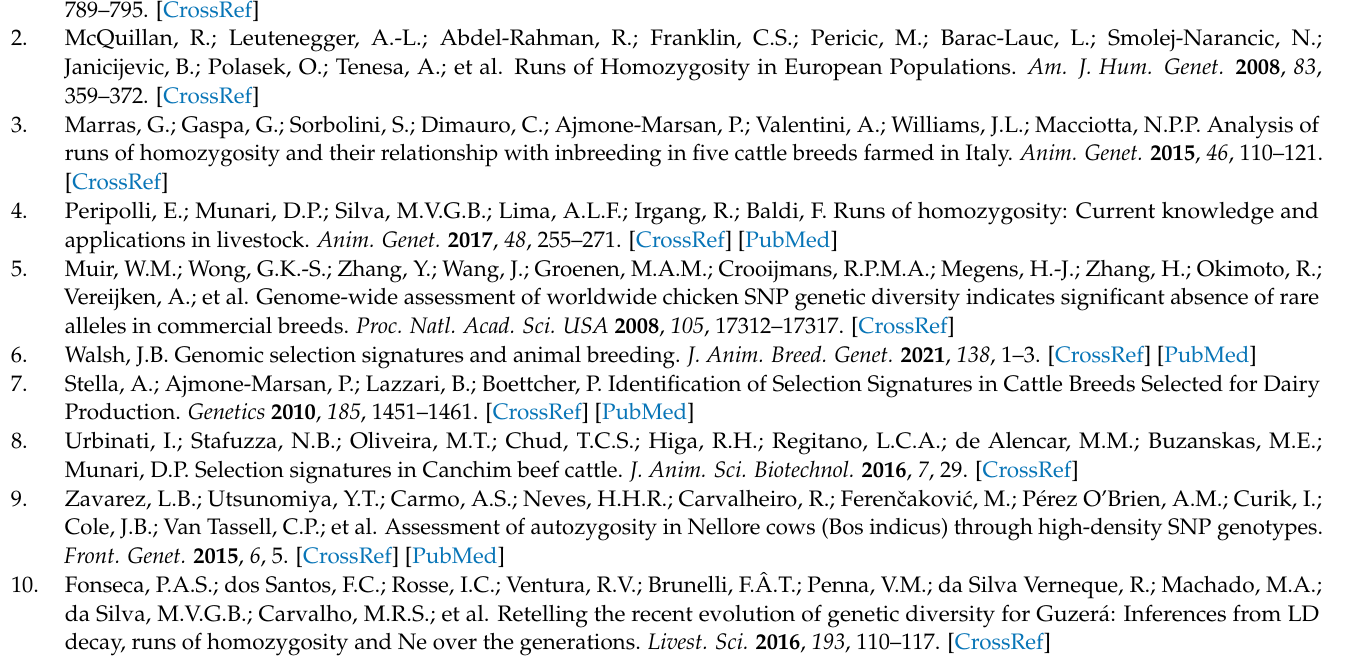
for seventeen worldwide sheep populations. Table S2. Runs of homozygosity (ROH) islands from seventeen worldwide sheep populations. Table S3. Heterozygosity-rich region (HRR) islands from seventeen worldwide sheep populations. Table S4. Gene ontology (GO) terms and pathways associated with genes identified within runs of homozygosity (ROH) and heterozygosity-rich region (HRR) islands from different sheep groups. File S1. Tableau file with all visualizations included in this